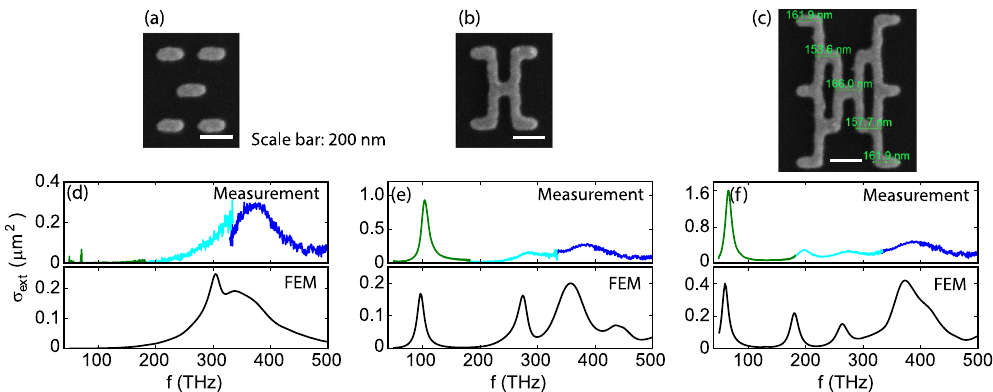
Figure 2. SEM images and comparison of measured (colored lines) and simulated (black lines) extinction cross sections of ( a , d ) the pentamer, ( b , e ) the first and ( c , f ) the second generation of dendritic antennas. The extinction cross section is measured with three detectors for different frequency ranges. Green: Bruker HYPERION Series FTIR; cyan: home-made FTIR; blue: Ocean optics fiber-coupled grating